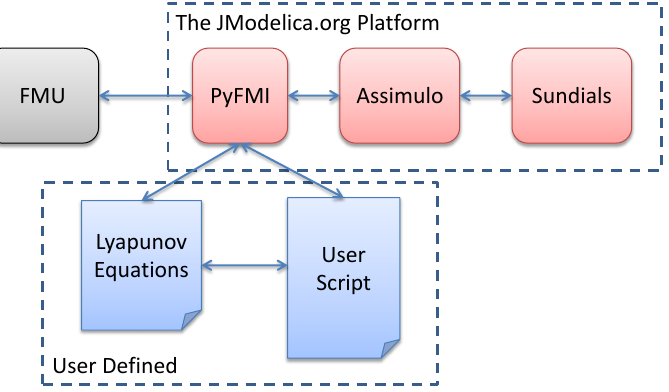
Figure 3. The simulation capabilities of the JModelica.org platform. An FMU is